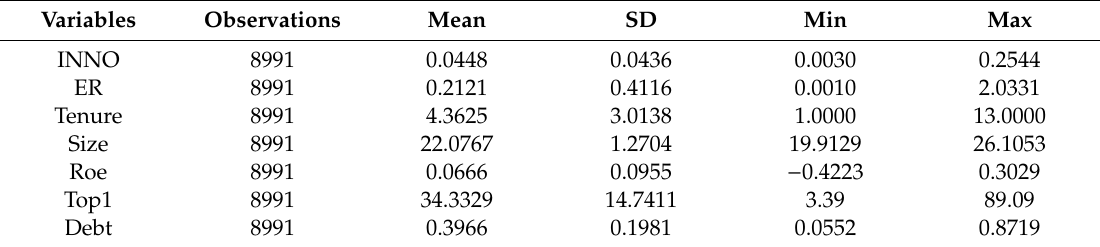
Table 2. Descriptive statistics of